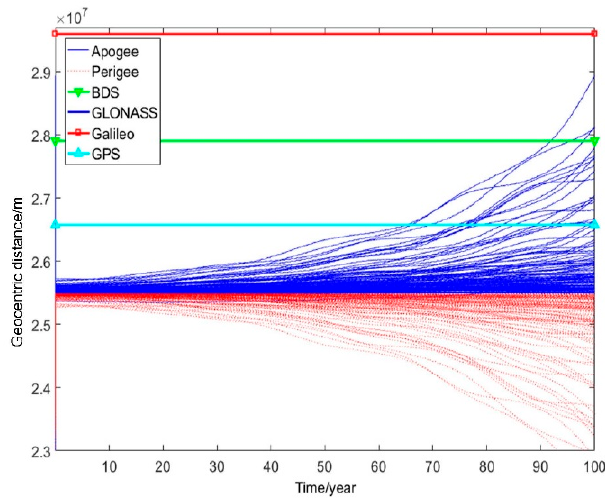
Figure 11. Orbital variations of GLONASS disposed satellites over 100 years.